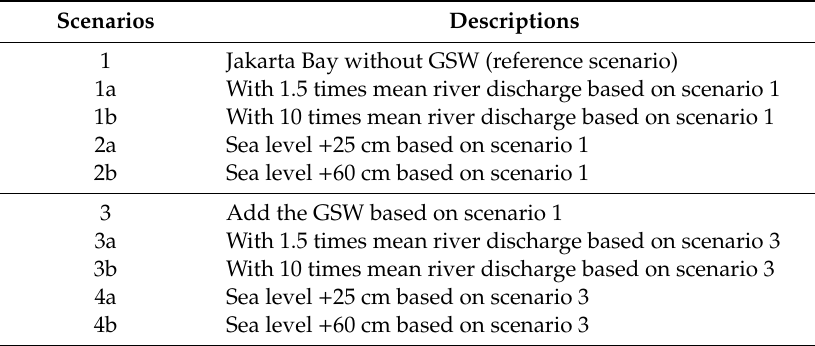
Table 2. Descriptions of di ff erent scenarios for Jakarta Bay. Scenario 1 is the reference scenario before the construction of the GSW and covers the 3–19 June 2015